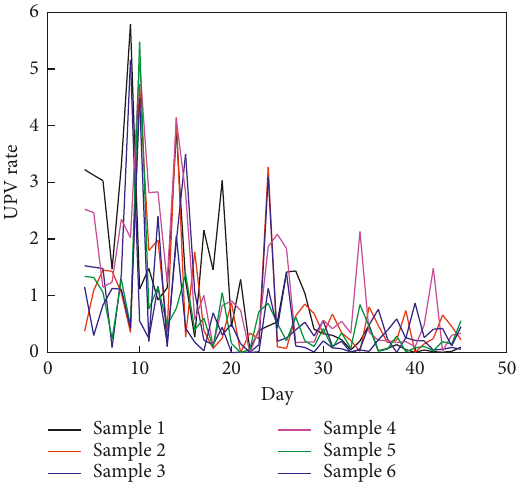
Figure 6: UPV rate versus curing period for FMLS.